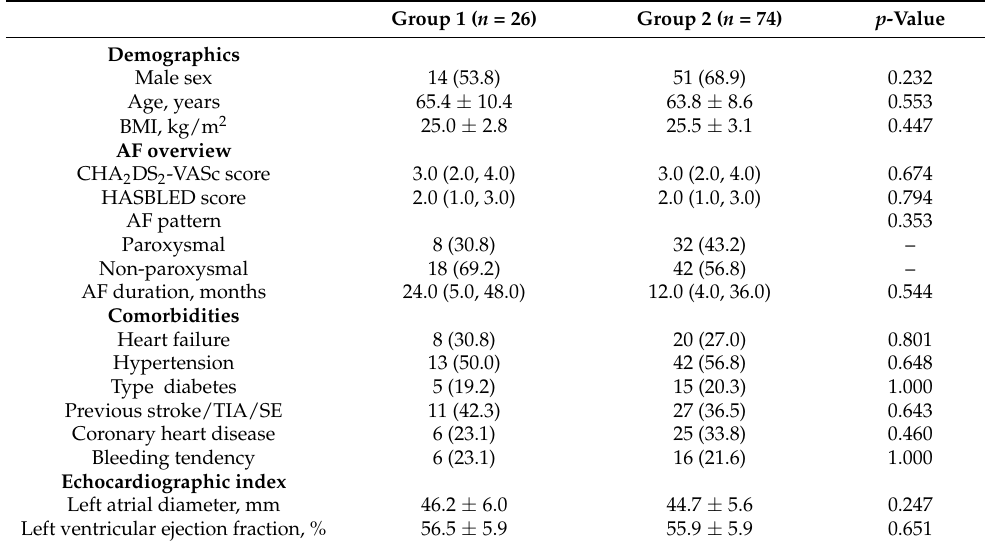
Table 1. Patient characteristics at baseline.